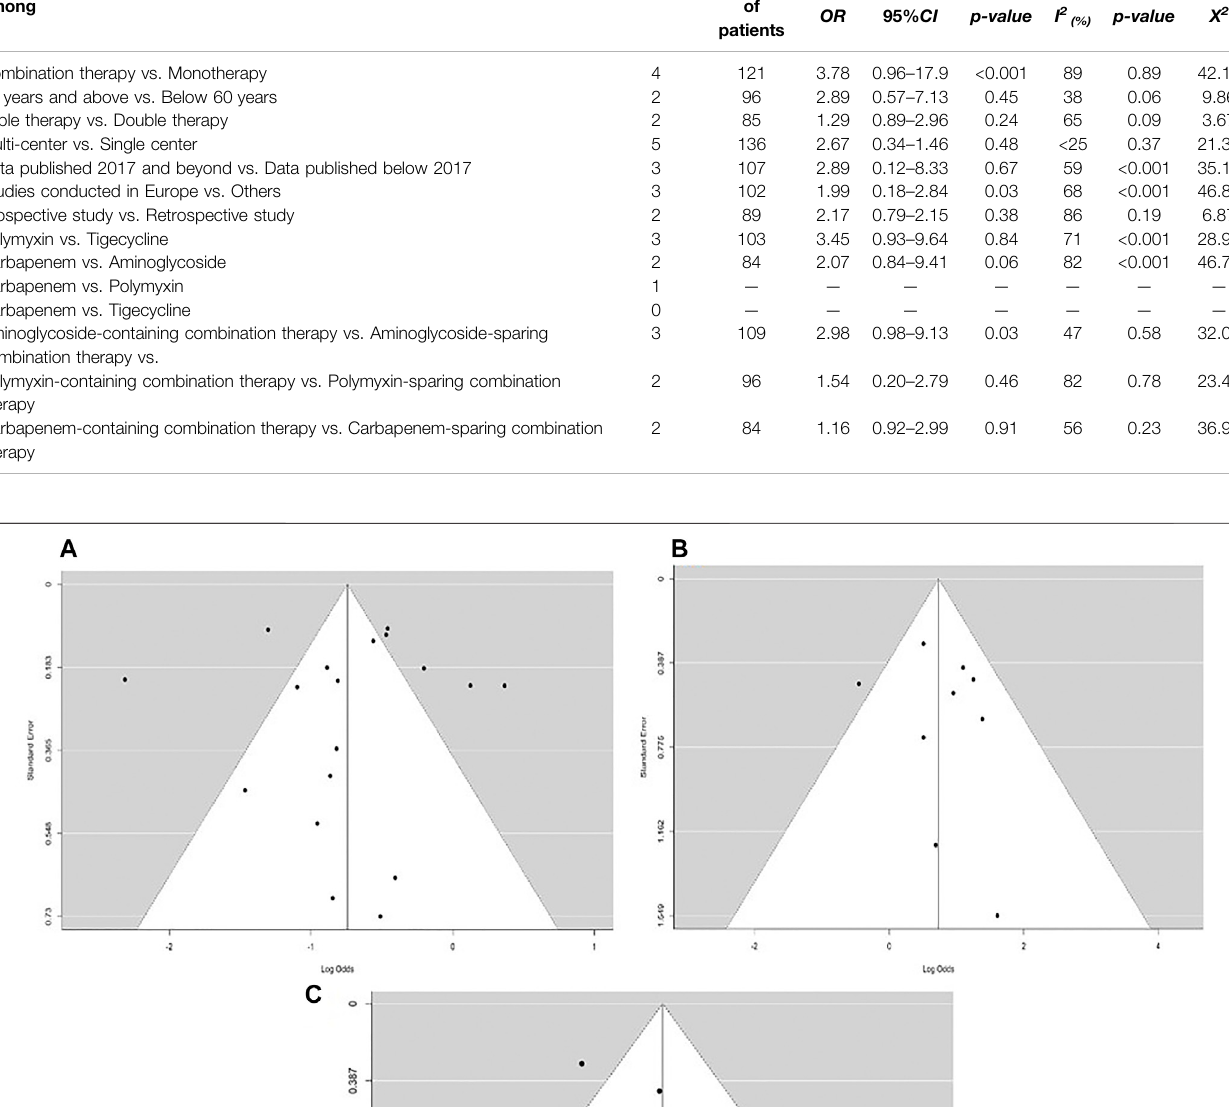
Frontiers in Pharmacology |